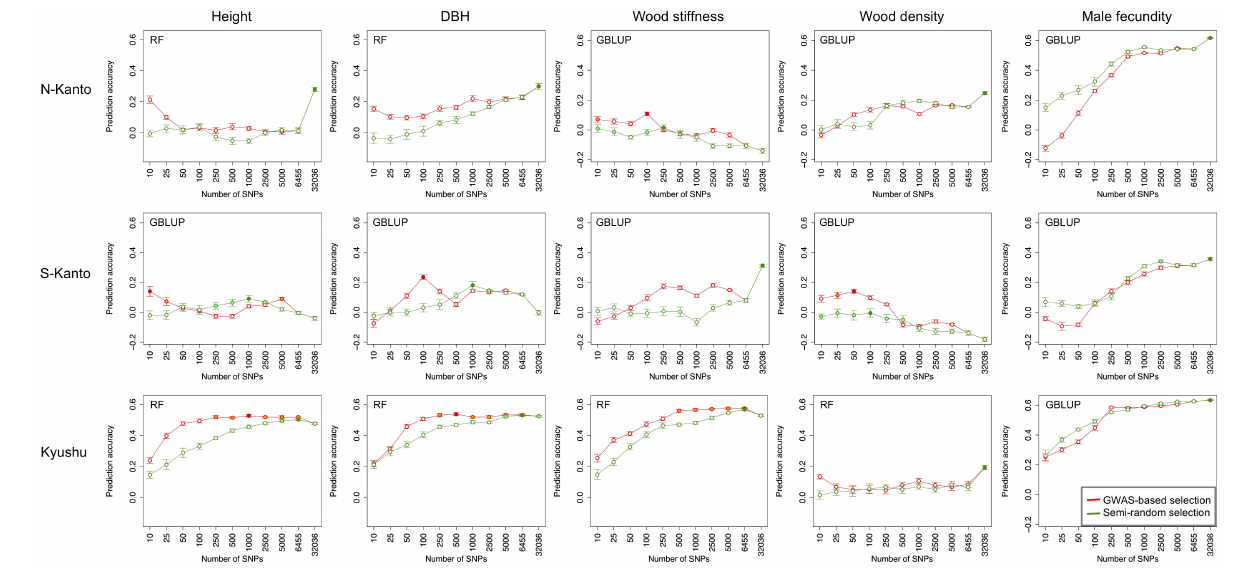
FIGURE 6 | Transitions of prediction accuracies as a function of the number of SNPs selected, based on the GWAS result for each population–trait combination. Results for traits of height, DBH, wood stiffness, wood density and male fecundity are shown in columns for the N-Kanto, S-Kanto and Kyushu populations shown in the upper, middle and lower rows, respectively. Orange and light-green colored circles indicate that those are not significantly different from the highest values (red and green colored circles, respectively) with t -test ( p ≥ 0.05). Error bars represent SE. The model (G-BLUP or RF) showing better prediction accuracies in Table 3 was